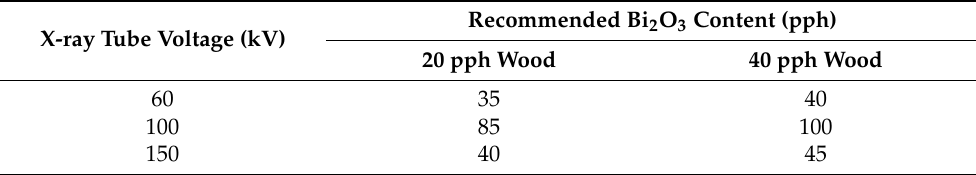
Table 4. Recommended Bi 2 O 3 contents in WPVC composites containing 20 pph and 40 pph wood particles for attenuation of X-rays generated from a tube with supplied voltages of 60, 100, and 150 kV.